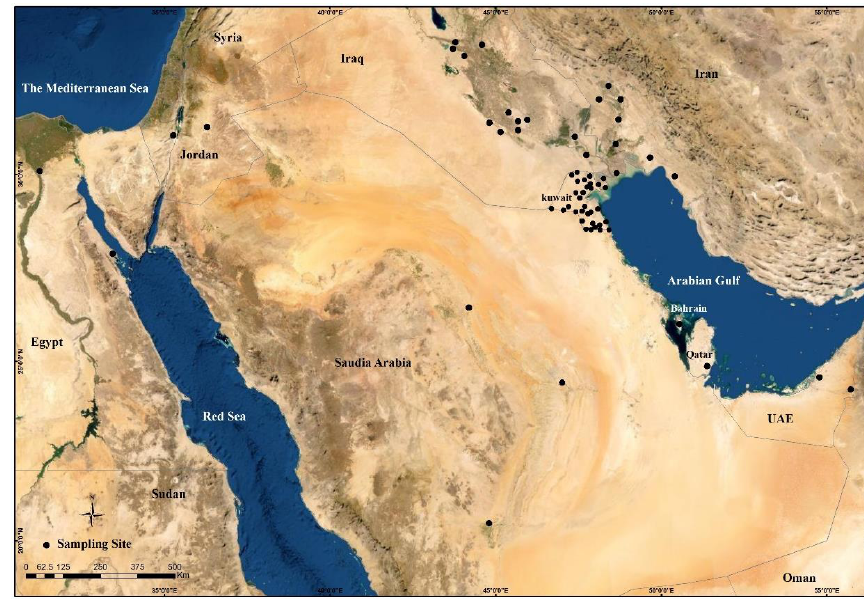
Figure 4. Deposited dust sampling locations in the Middle East.